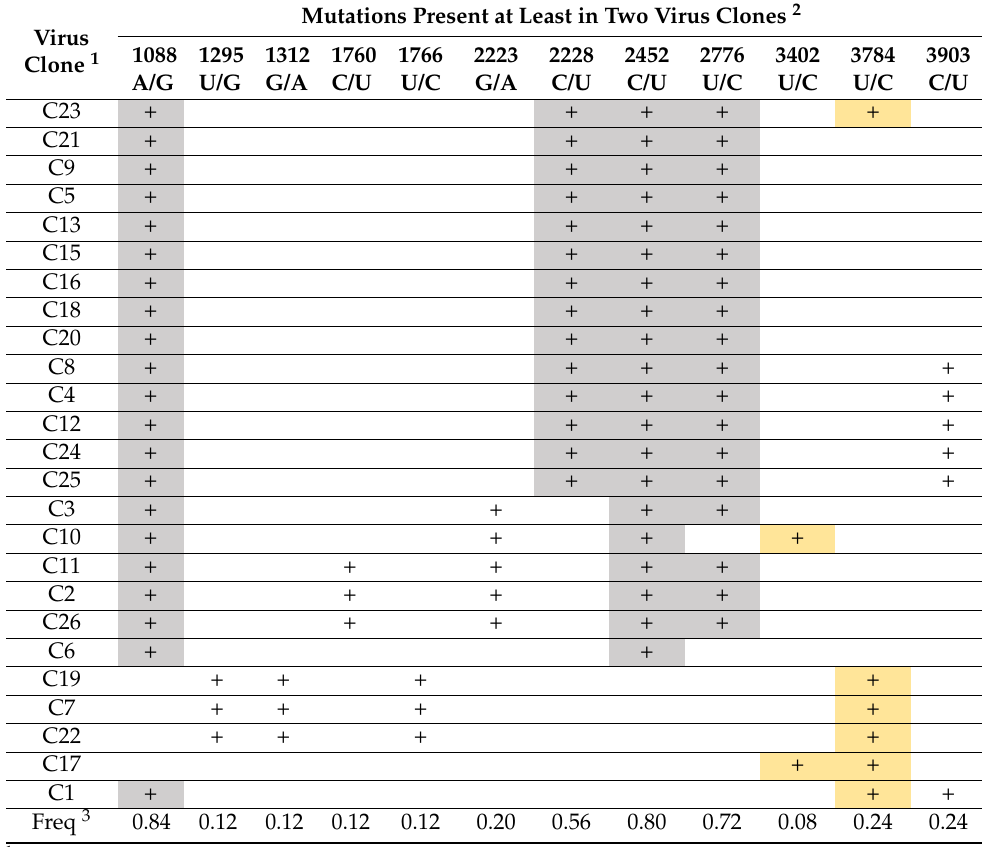
Table 2. Mutations present in the genomic sequences of the virus clones isolated from lineage L1 at transfer